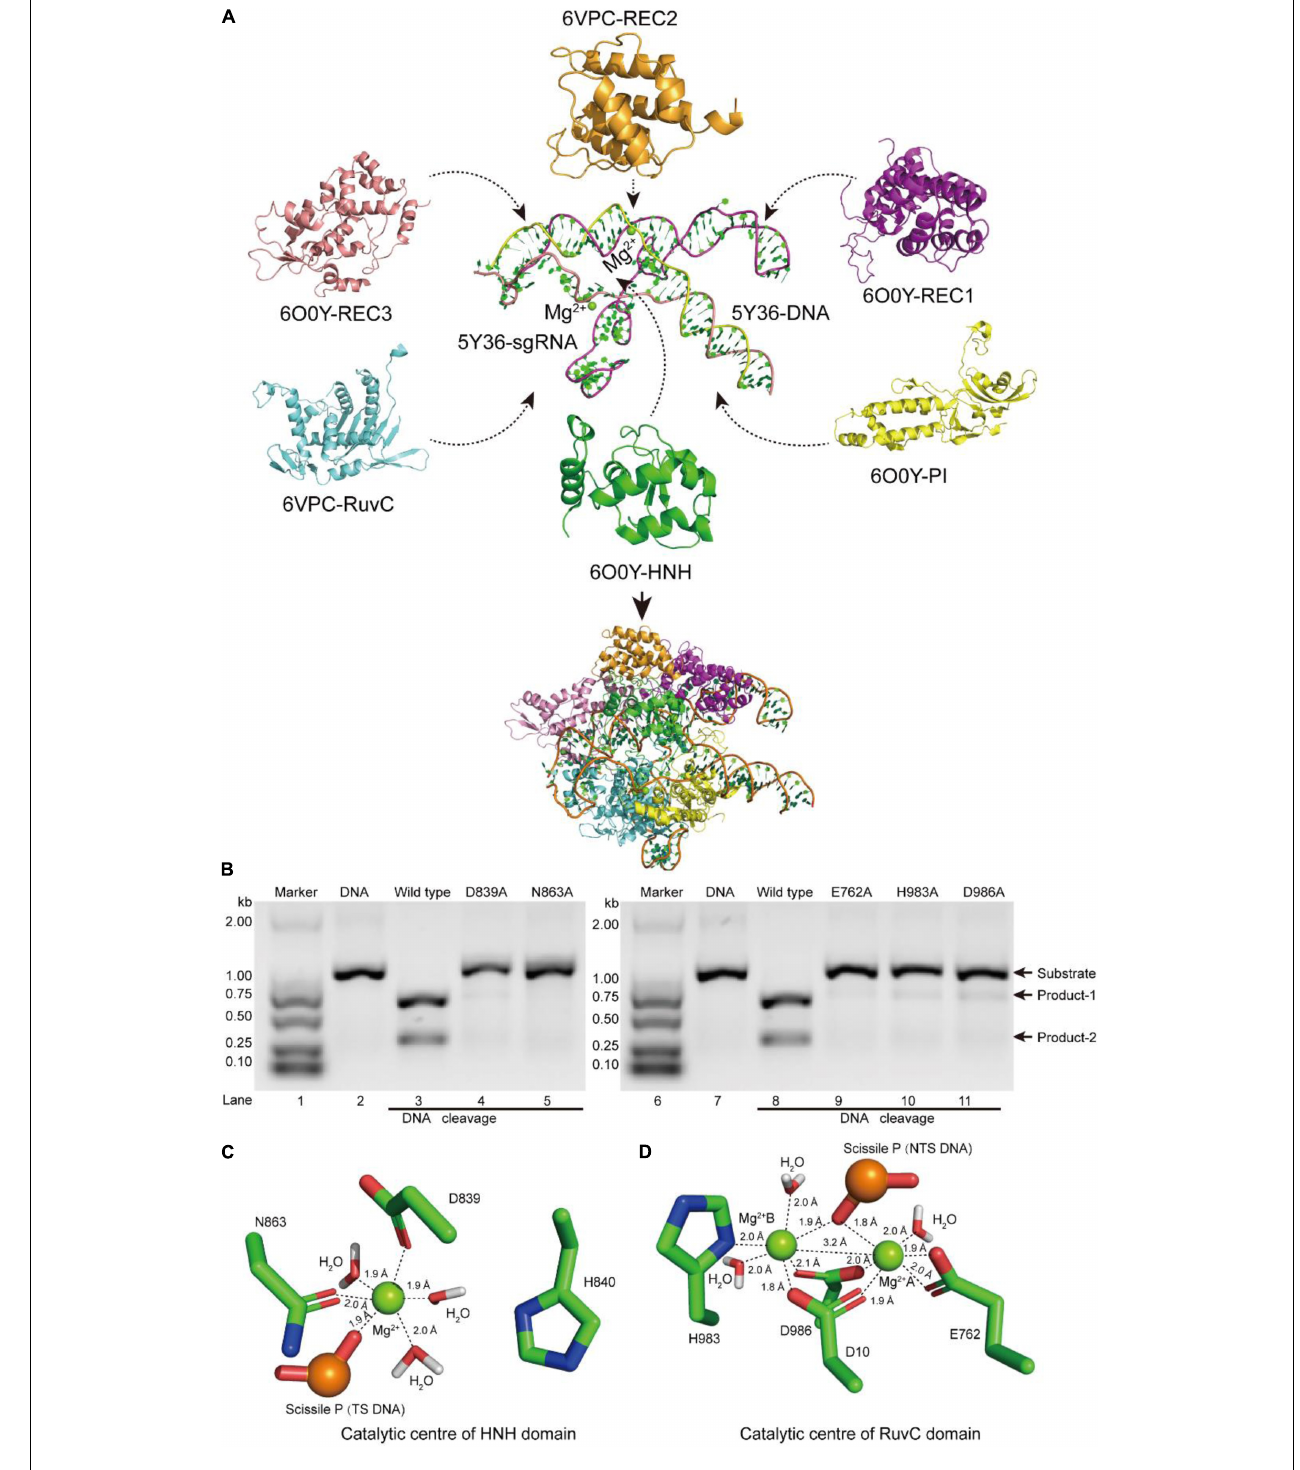
FIGURE 1 | Atomic model of the ternary complex in the DNA cleavage state. (A) The structural assembly of SpCas9–sgRNA–DNA ternary complex. Domains HNH, REC1, REC3, and PI come from atomic model 6O0Y, and domains REC2 and RuvC derive from atomic model 6VPC. (B) In vitro cleavage activities of SpCas9 and its mutants. These mutation sites are located in the HNH and the RuvC domains, respectively. The target DNA molecules are cleaved into two products (product-1 and -2). (C,D) The Mg 2 + ion coordination of the catalytic centers (HNH and RuvC, respectively). The distances between ligands and corresponding Mg 2 + ions are about 2.0